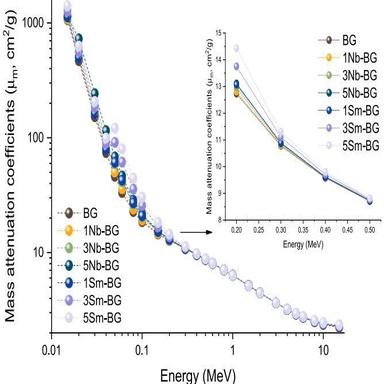
Variation of mass attenuation coefficients (μm) as a function of increasing energy.